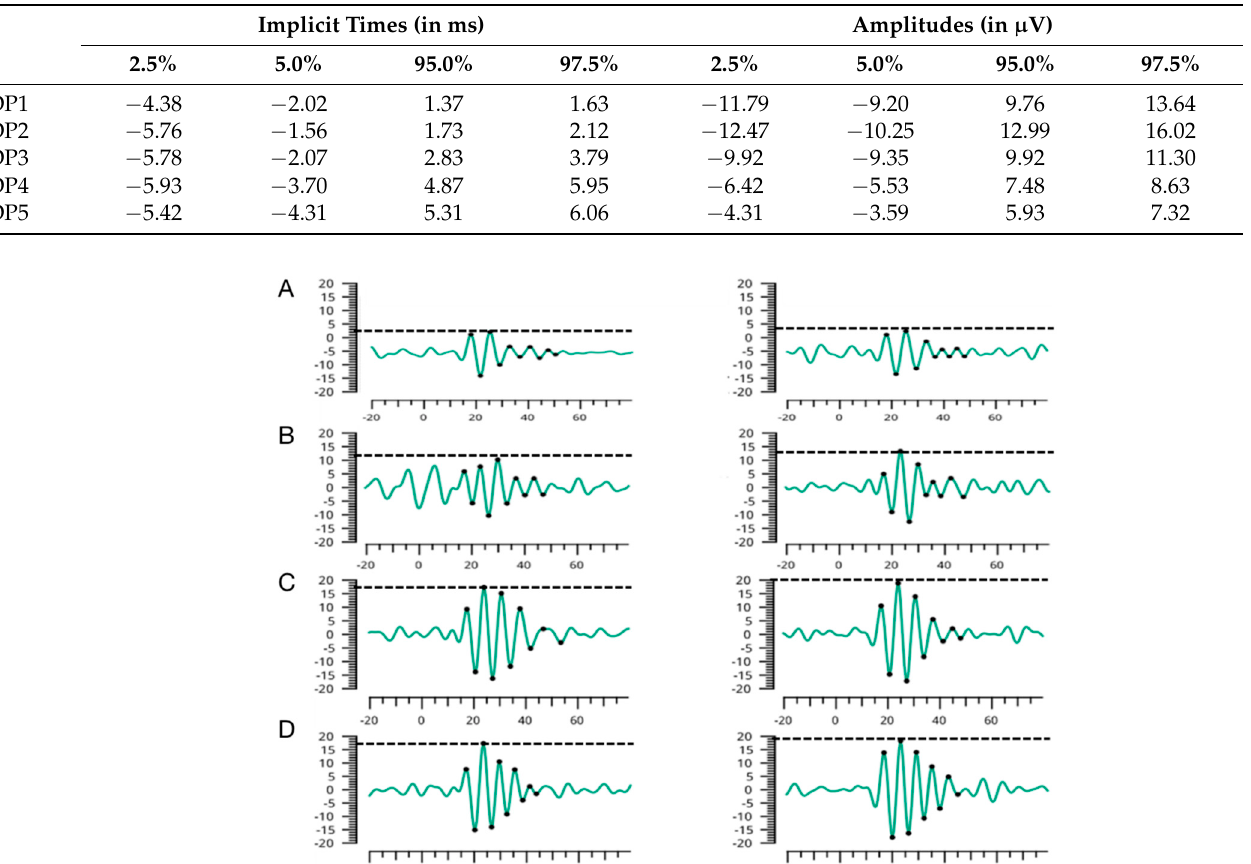
Table 2. Additive amounts for 2.5%, 5%, 95%, and 97.5%.